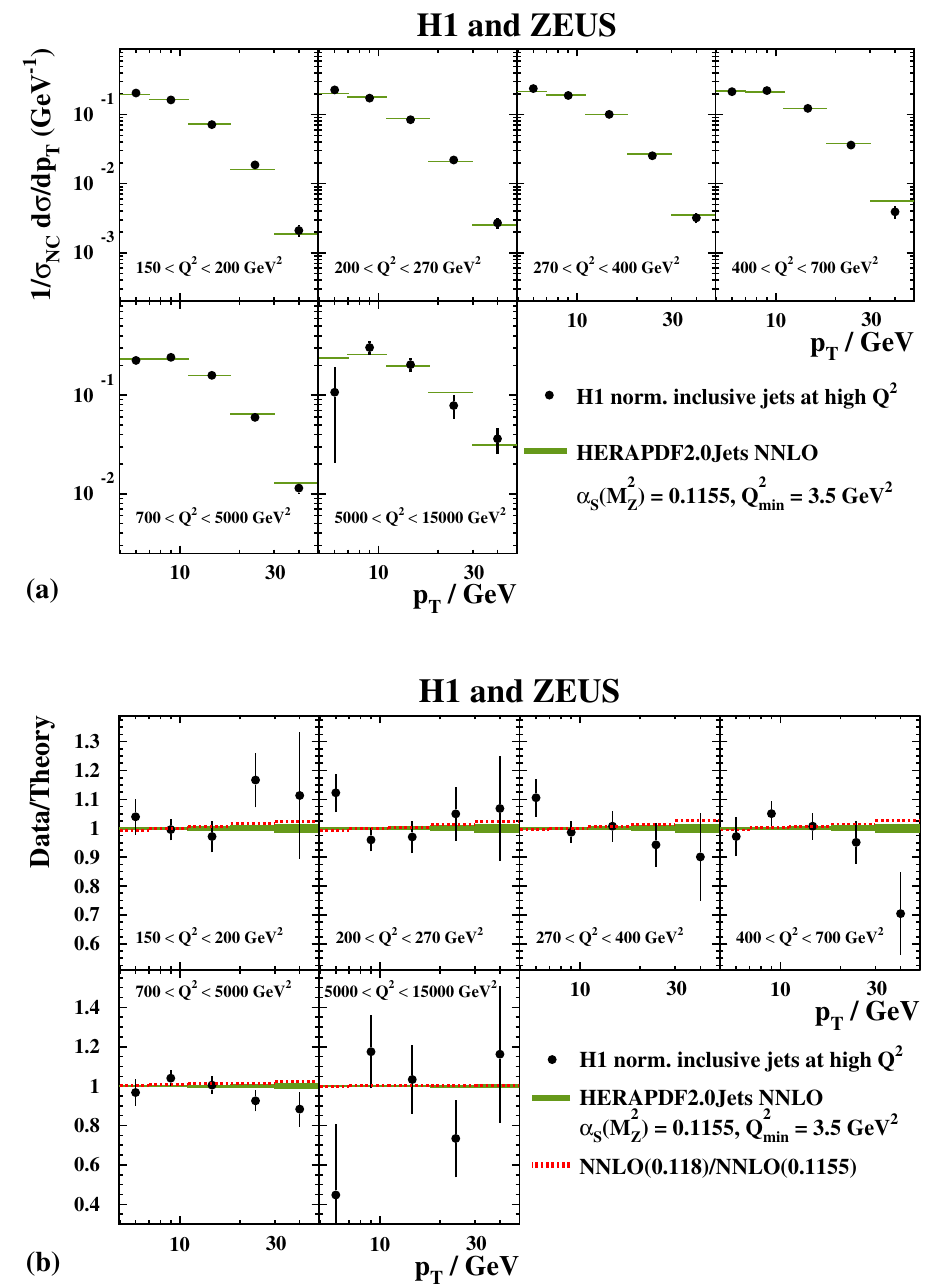
Fig. 17 a Differential jet-cross-section predictions, d σ/ d p T , based tions based on HERAPDF2.0Jets NNLO. The bands represent the total ) = 0 . 1155 in bins of Q 2 on HERAPDF2.0Jets NNLO with α s ( M 2 uncertainties on the predictions excluding scale uncertainties; the bands Z are so narrow that they mostly appear as lines. Error bars indicate the between 150 and 15,000GeV 2 compared to H1 data normalised to neu- full uncertainties on the data and are smaller than the symbols for most tral current (NC) inclusive cross sections [13,14]. Only data used in the bins in ( a ). In b , the ratio of predictions based on HERAPDF2.0Jets fit are shown. b Measured normalised cross sections divided by predic- NNLO with